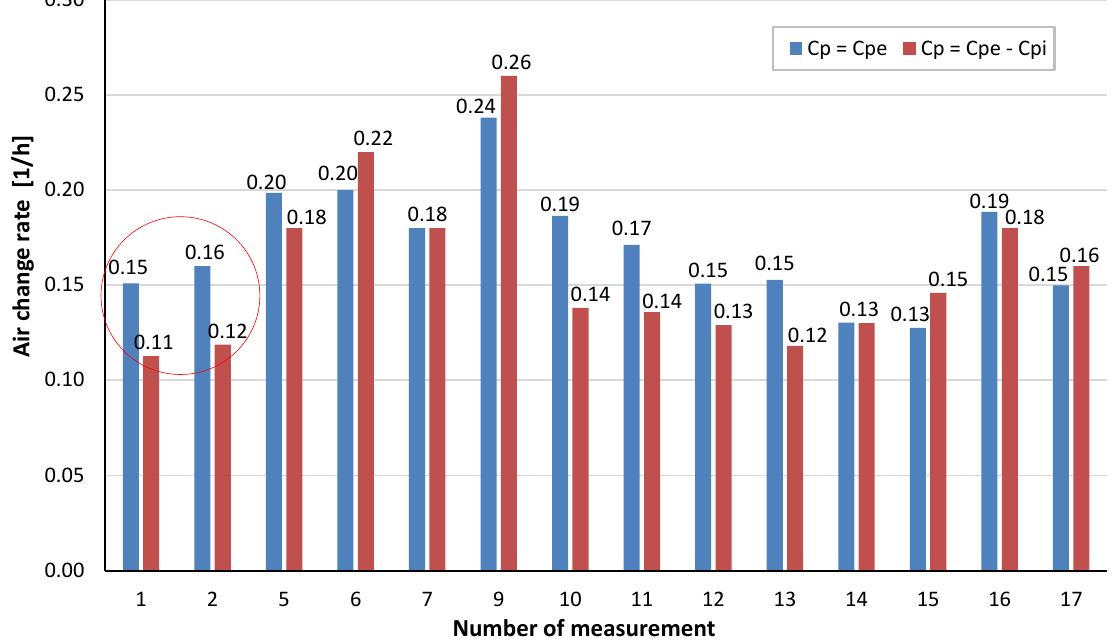
Figure 9. The values of air change rate without considering the influence of openings– C p = C pe and when considering the influence of openings C p = C pe − C pi for lower wind speed v = 1.1 m/s–4.1 m/s.